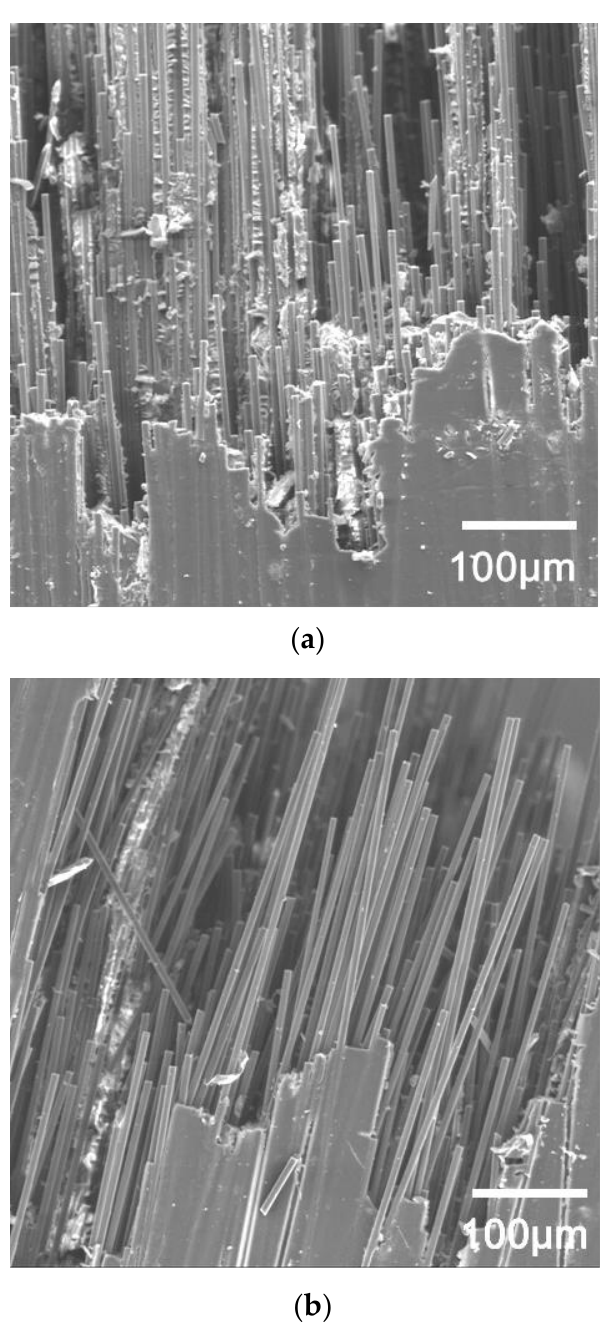
Figure 7. SEM image of the fracture surface of the CFRE sample. ( a ) Original sample. ( b ) Specimen after the hydrothermal treatment.